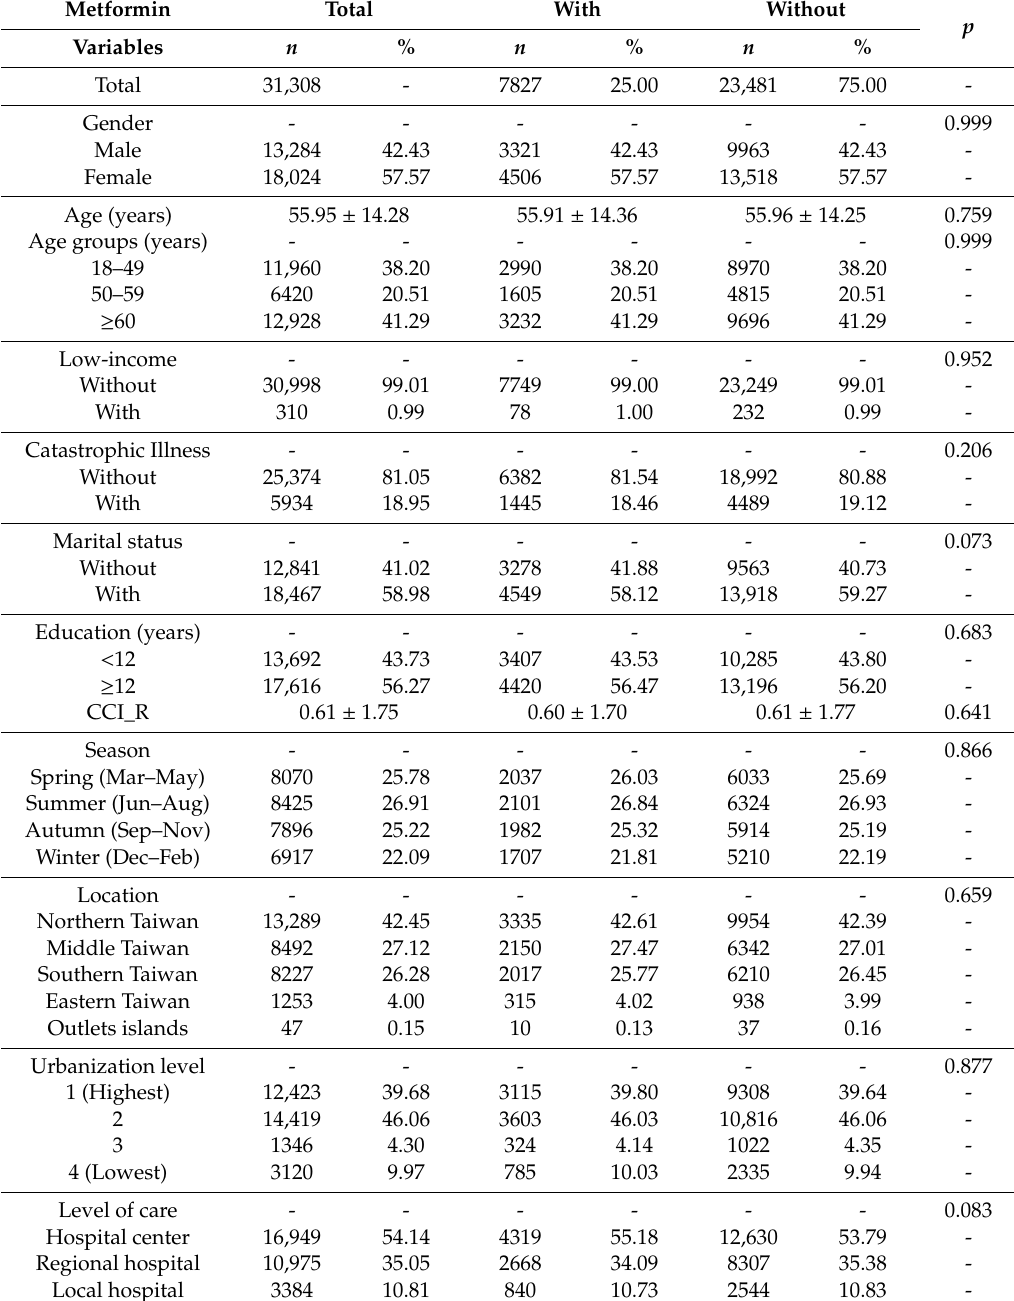
Table 1. Characteristics of study in the